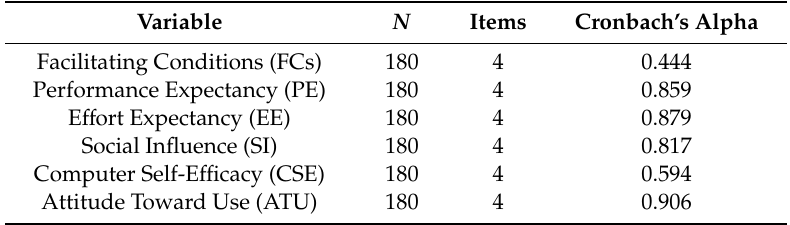
Table 4. Overview of independent variables’ Cronbach’s alpha coe ffi